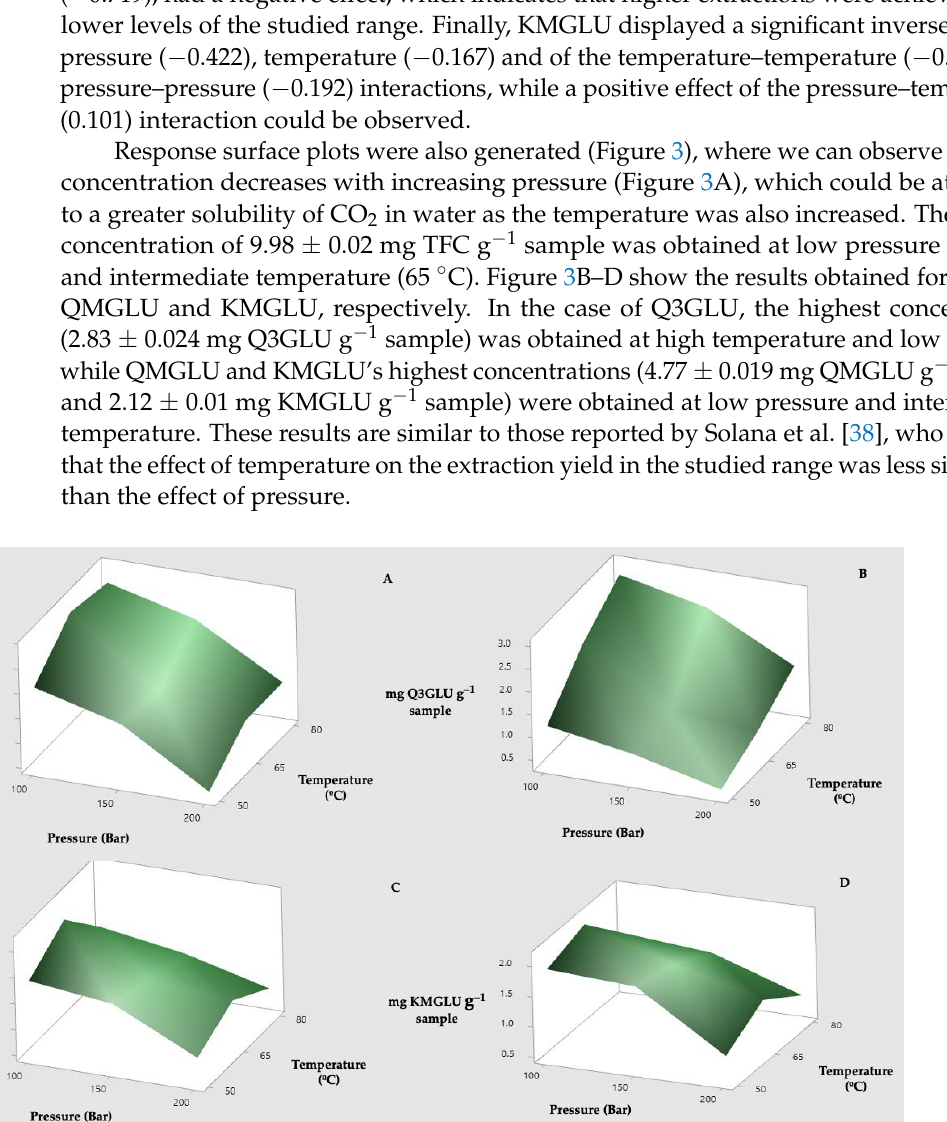
(4) Table 3. Experimental values (mg g −1 sample) vs. design-estimated values (mg g −1 sample). Observed Values